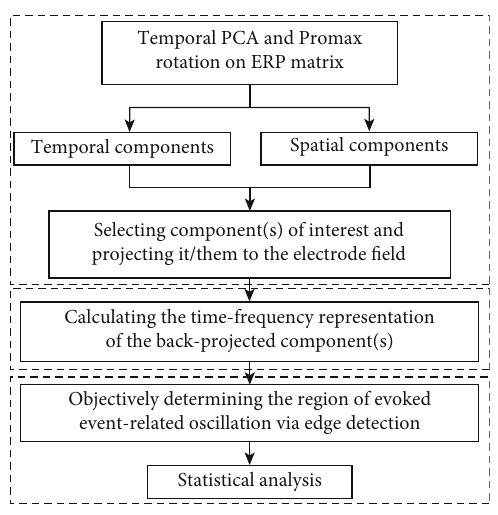
Figure 1: The diagram for extracting evoked event-related oscillations (EROs) from ERP datasets using the proposed method. First, exploring the temporal and spatial components of interest using temporal principal component analysis (t-PCA) and Promax rotation and projecting them to the electrode fi elds. Second, transforming the projection of the components of interest into time-frequency representations (TFRs) using complex morlet continuous wavelet transform. Third, determining the time and frequency positions of evoked event-related oscillation objectively using edge detection technique for statistical